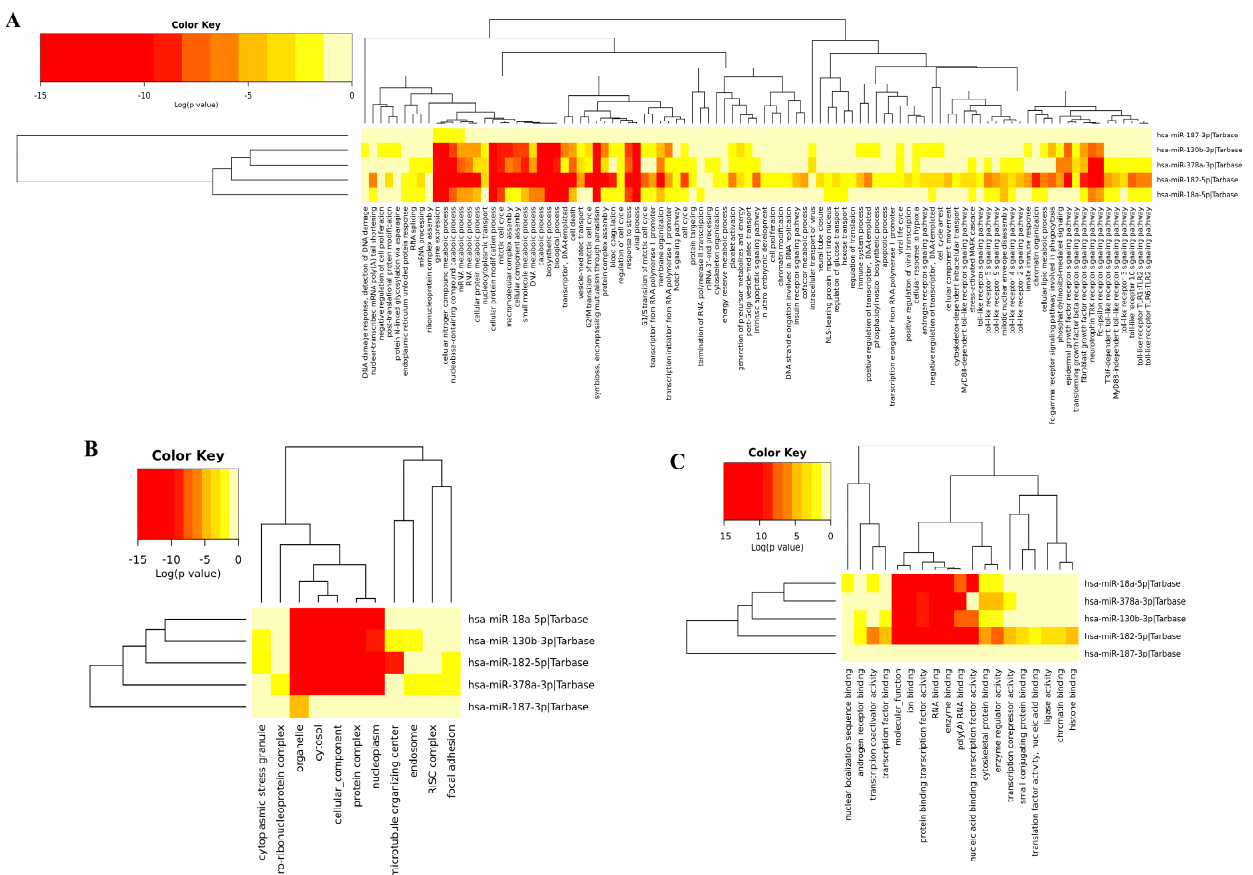
Figure 6. Gene ontology of upregulated miRNAs. ( A ) Biological processes. ( B ) Cellular components. ( C ) Molecular functions.